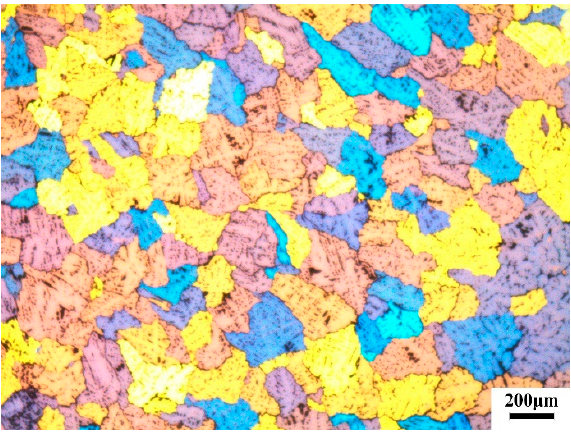
Figure 1. Base material microstructure before extrusion. Before extrusion, the homogenized 6063 aluminum billets were cut and machined to Ø86 × 300 mm. The extrusion experiment was carried out on an 800 ton extruder at ram speeds of 3 mm/s , 7 mm/s , 9 mm/s , and 11 mm/s, respectively. The extrudate tempera- ture was measured and recorded by a 3T temperature sensor. The SD3000 data acquisition and analysis software application was used in conjunction with the 3T pyrometer system.